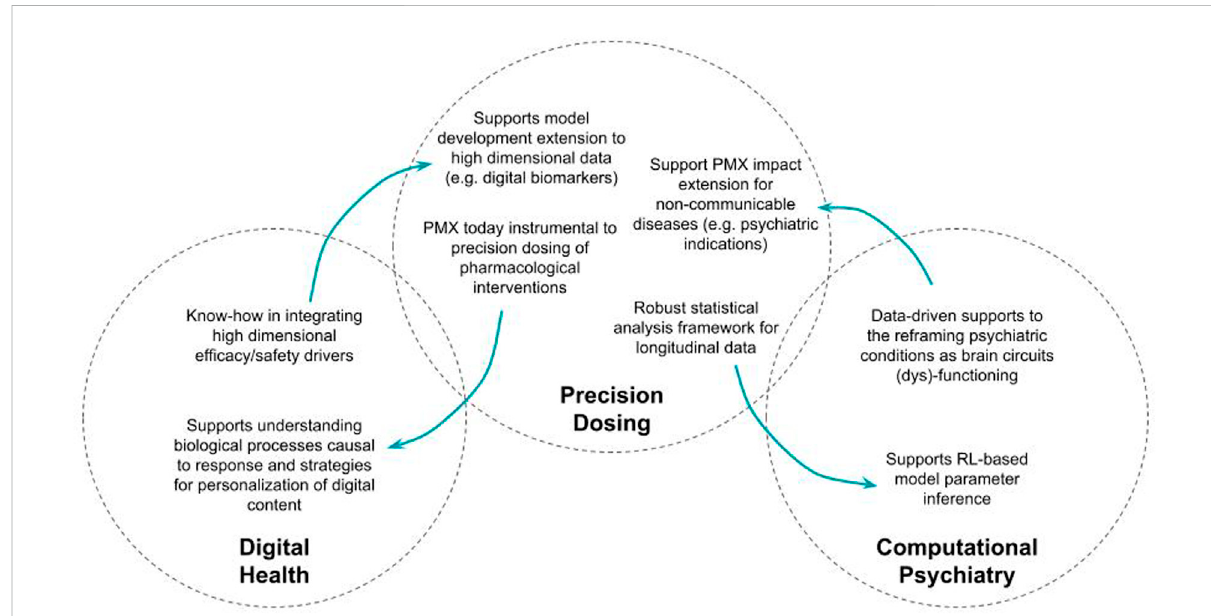
FIGURE 1 Illustration of the mutual bene fi ts of increased permeability between model-based approaches to precision dosing and digital health, on one hand, and computational psychiatry on the other